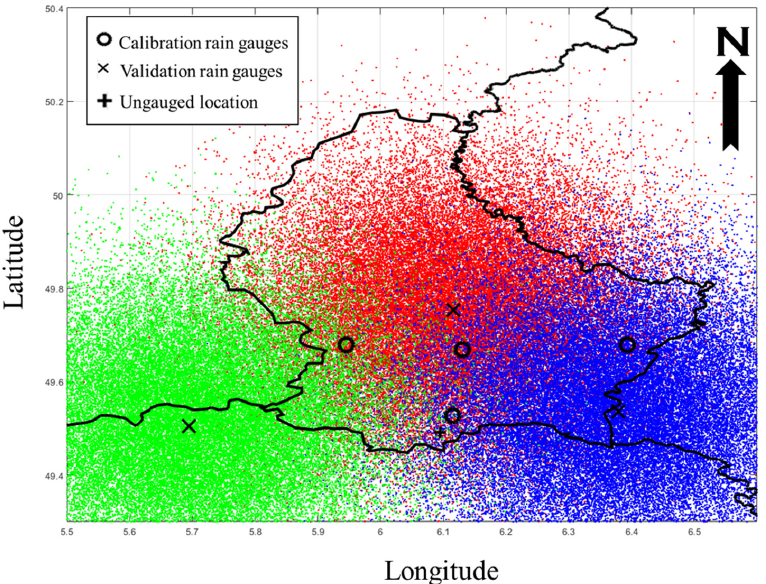
Figure 4. Generating random data using a multivariate normal distribution (red, blue and green points are random data around cluster centers/calibration stations).